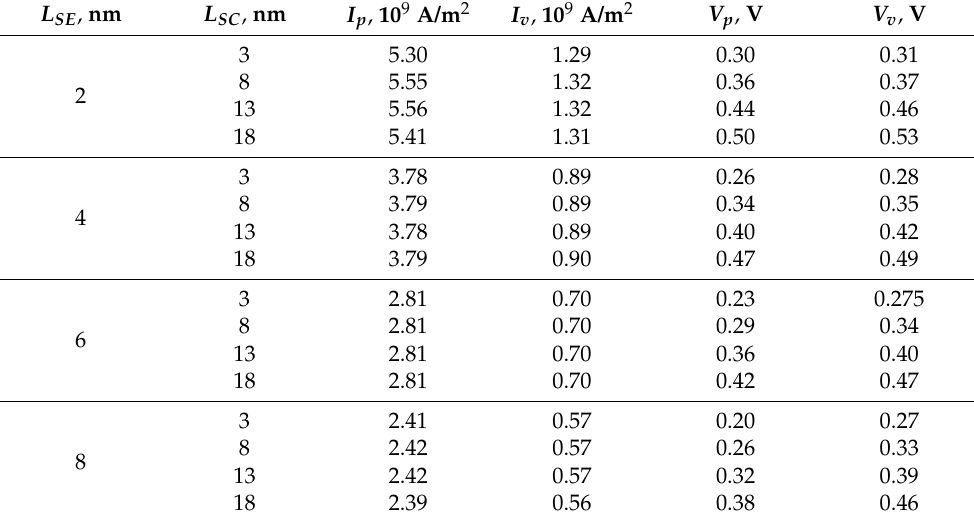
Table 2. The values of peak current I p , valley current I v , peak voltage V p , and valley voltage V v for different thicknesses of spacer emitter and spacer collector. The results are presented for the resonant tunneling Structure #1.